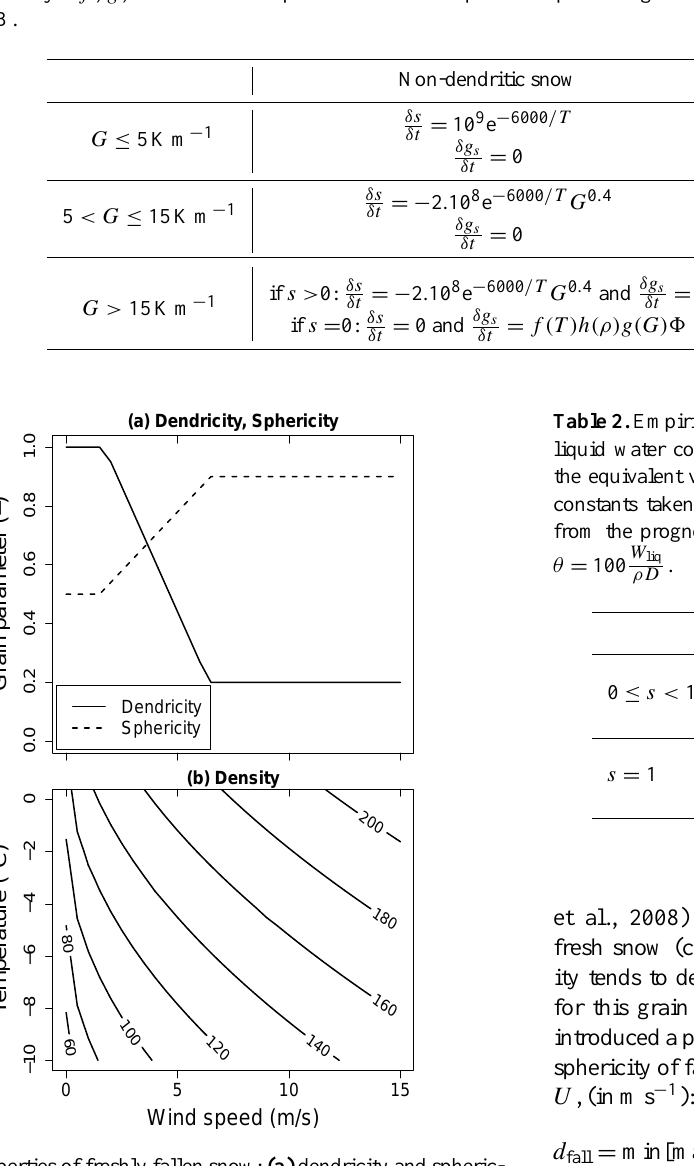
Fig. 3. Properties of freshly fallen snow: (a) dendricity and spheric- ity as a function of wind speed; (b) density as a function of air tem- perature and wind speed.